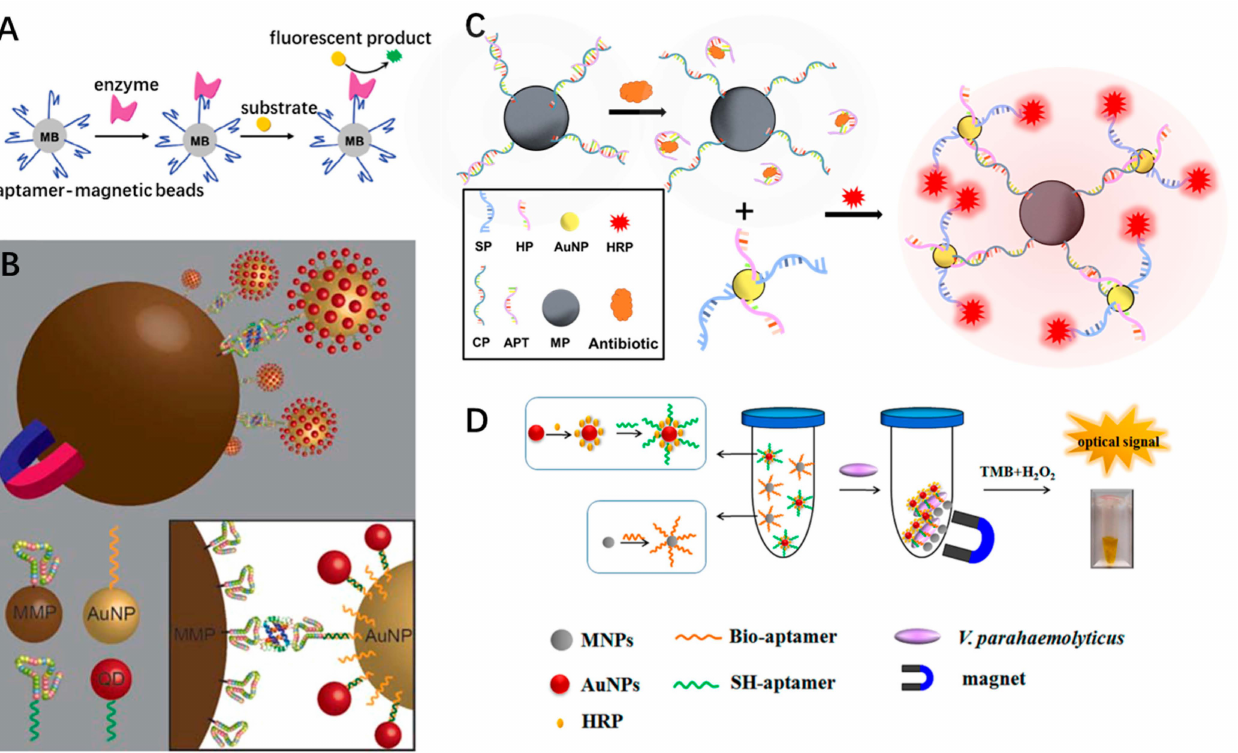
Figure 5. Aptamer-capture assay methods via fluorometric and colorimetric sensing. ( A ) Schematic di- agram of the aptamer–enzyme biosensor for enzyme detection, reproduced with permission from [63]. Copyright 2011 American Chemistry Society. ( B ) Aptamer-based sandwich assay for malaria antigen detection, reproduced with permission from [65]. Copyright 2017 American Chemistry Society. ( C ) A colorimetric aptasensor based on signal amplification for the detection of antibiotics. ( D ) A colori- metric aptasensor based on HRP for V. parahaemolyticus detection, reproduced with permission from [68]. Copyright 2015 American Chemical